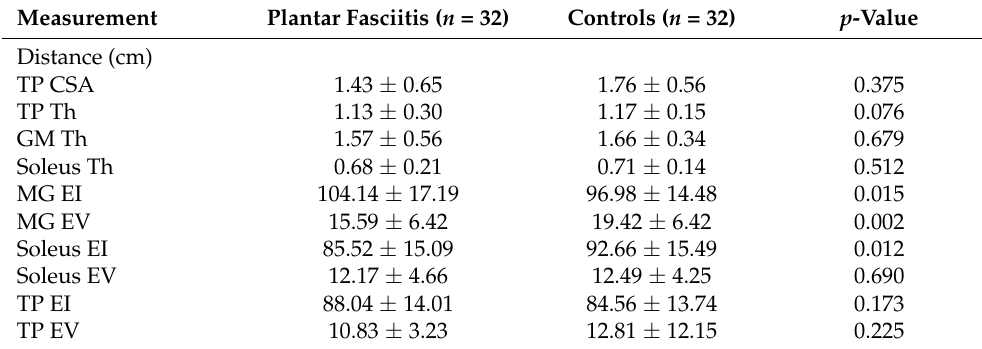
Table 2. Ultrasound imaging measurements of the intrinsic muscles thickness, CSA, EI and EV.